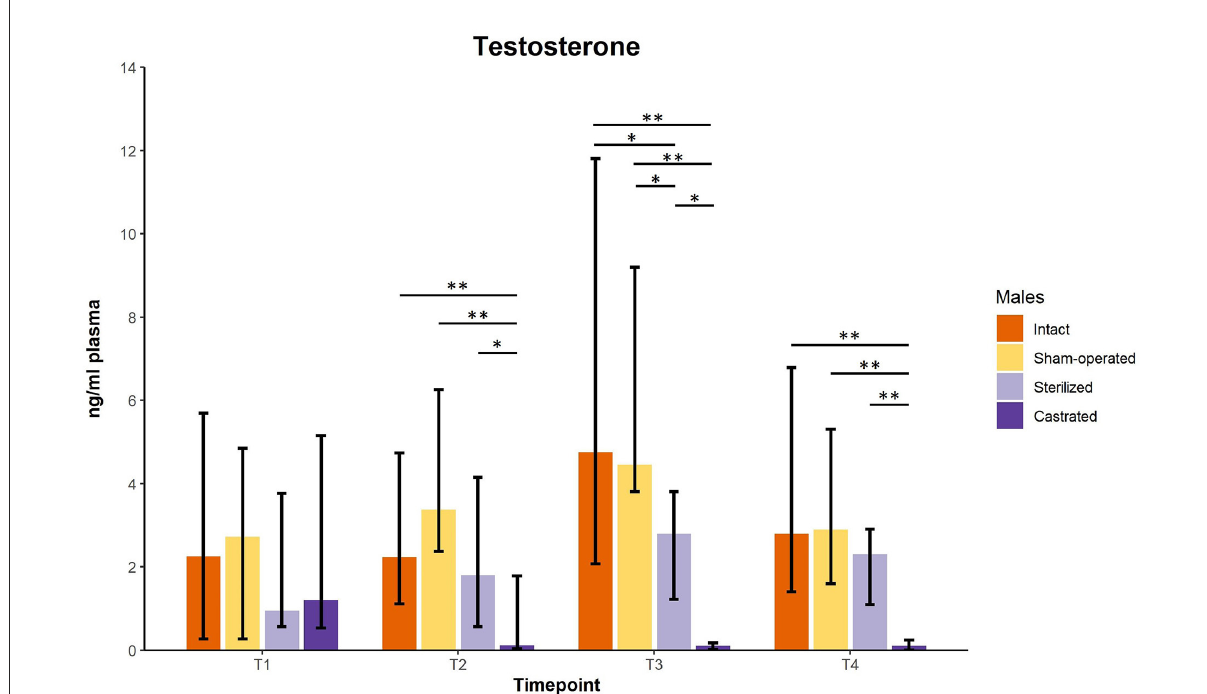
FIGURE1 Testosterone concentrations in ng/ml plasma of intact, sham-operated, sterilized and castrated males. Data are presented as medians, minimum and maximum values. T1, testosterone concentrations before surgery; T2, testosterone concentrations about 5 days before start of experiment (1 male and 2 females were put together in a new enclosure); T3, testosterone concentrations 1 week after introduction into the new enclosure; T4, testosterone concentrations 2 weeks after introduction into the new enclosure. Statistics: Kruskal-Wallis tests, post-hoc